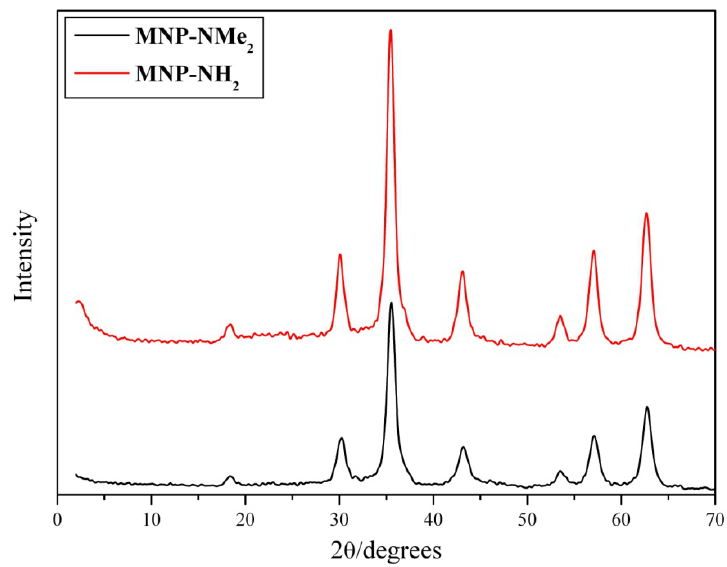
Figure 2. Powder X-ray Diffraction (XRD) patterns of base catalysts supported on magnetite